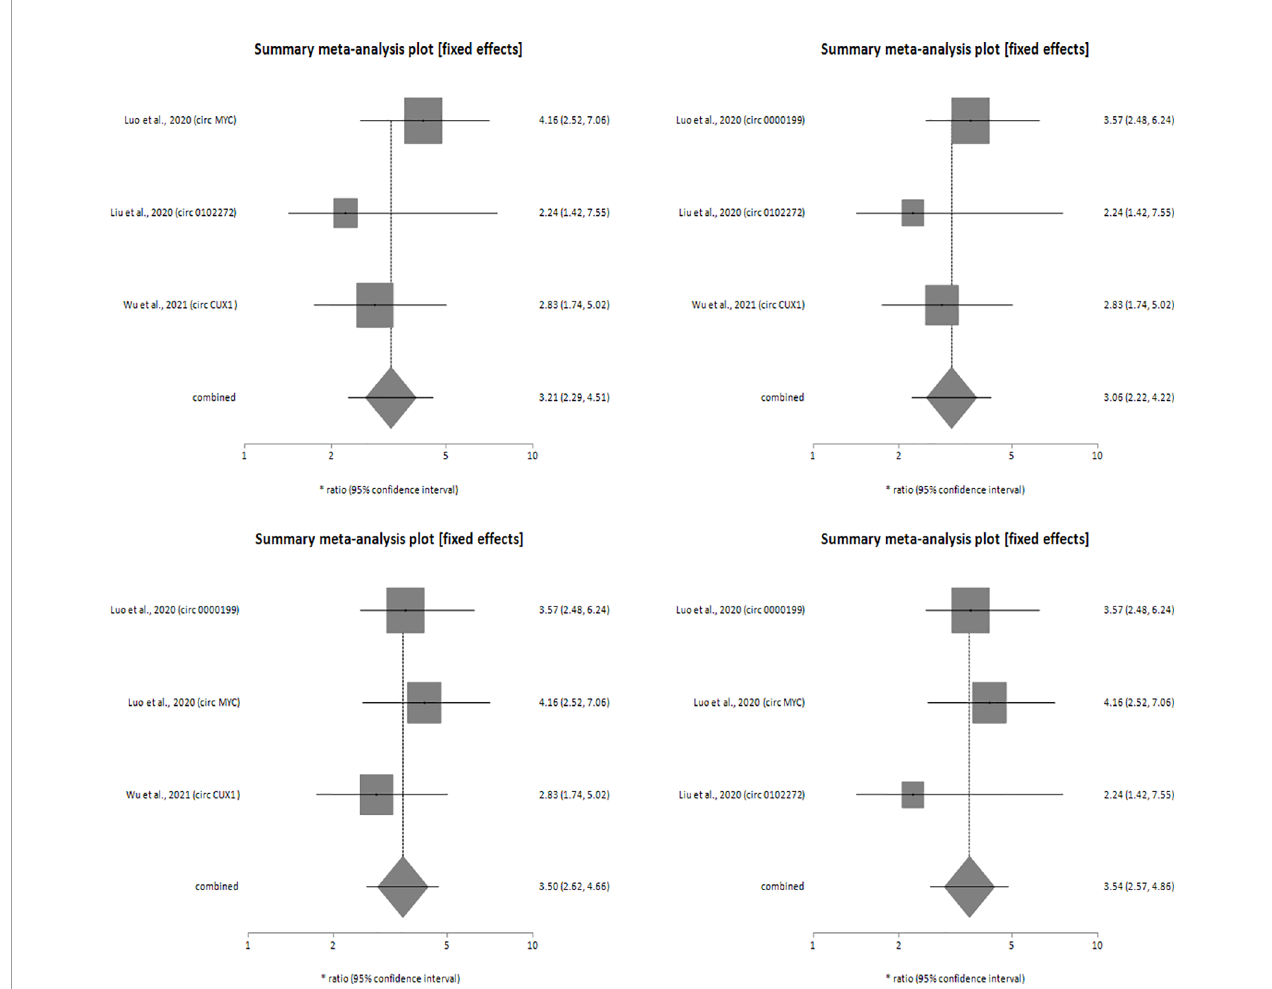
FIGURE 5 | Forest plots of sensitivity analysis showing the combined HR values at 95% CI upon sequential deletion of the studies included in multivariate analysis which reported upregulated circRNAs. Square shapes indicate the effect size of each upregulated circRNA pro fi le, while diamond shapes indicate the overall effect size. The 95% CI of each effect sizes are indicated by respective